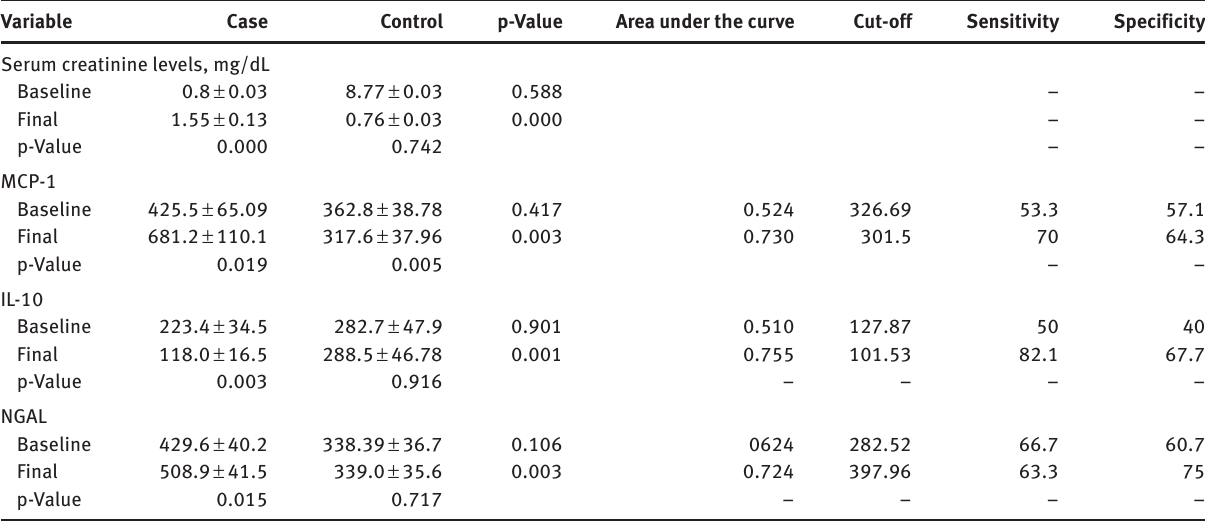
Table 2: Comparison of the level of serum creatinine and candidate biomarkers at baseline and final state between the case and control groups, and the diagnostic ability of each biomarker. Variable